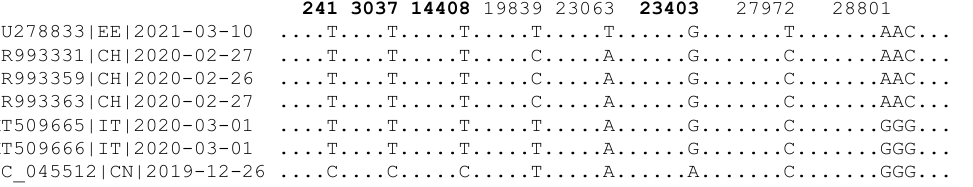
Figure 4. Sequence alignment summarizing all genomic variation among seven SARS-CoV-2 genomes. The genome sequence name is in the form of ACCN|Country_code|Collection_date. EE: Estonia; CH: Switzerland; IT: Italy; CN: China. The four nucleotide sites characterizing the D614G lineage are in bold.